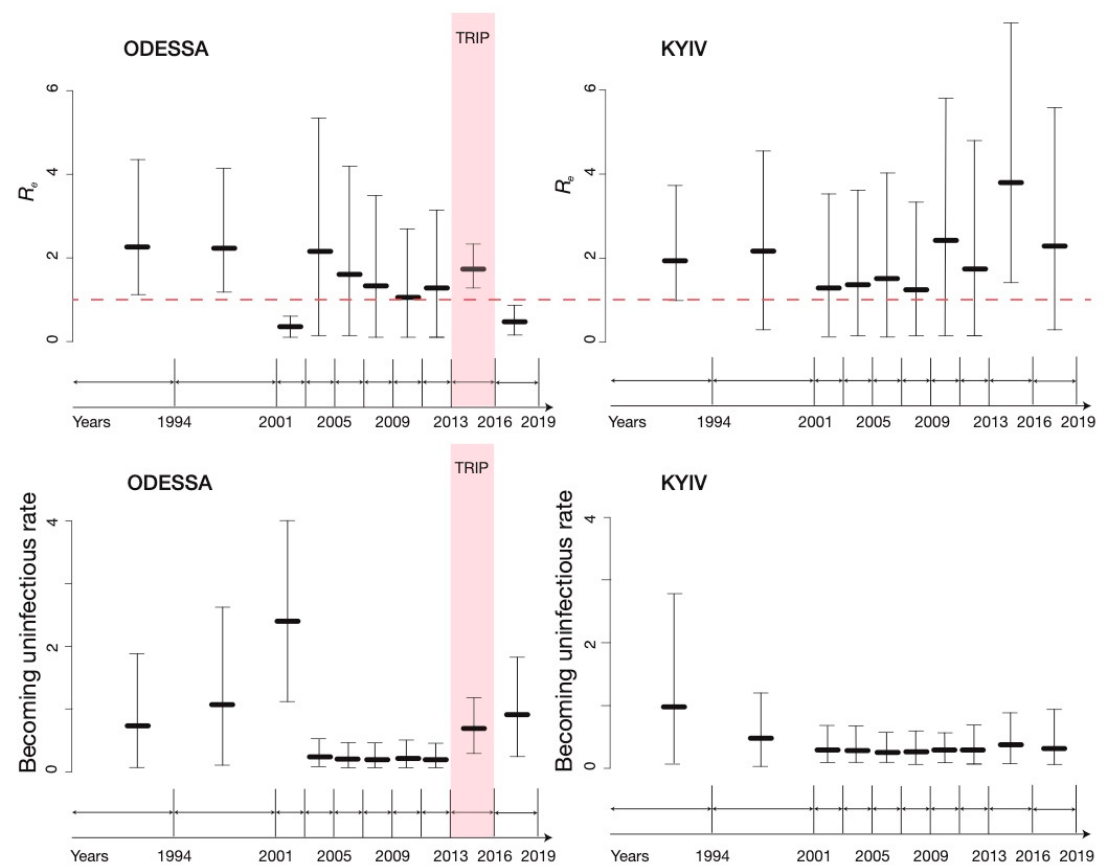
Figure 3. Estimates of the effective reproductive number, R e , in Odessa and Kyiv (top), where the red dotted line represents the epidemiological threshold of R e = 1; and the becoming uninfectious rate (bottom) obtained from the Odessa and Kyiv datasets by means of the BDSKY analysis.